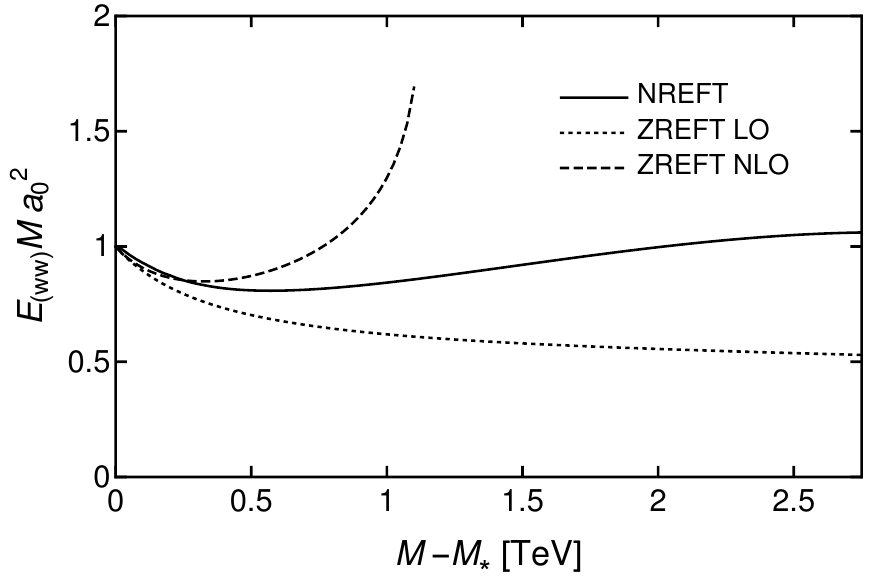
Figure 18 . The binding energy E of the wino-pair bound state divided by the universal ( ww ) approximation in eq. (3.17) as a function of the wino mass M . The binding energy for (cid:11) = 0 is shown for NREFT (solid line) and for ZREFT at LO (dotted line) and at NLO (dashed line). In the universal approximation and in ZREFT, a 0 = 1 =(cid:13) 0 is given by the Pad(cid:19)e approximant analogous to eq. (3.13) but for (cid:11) =